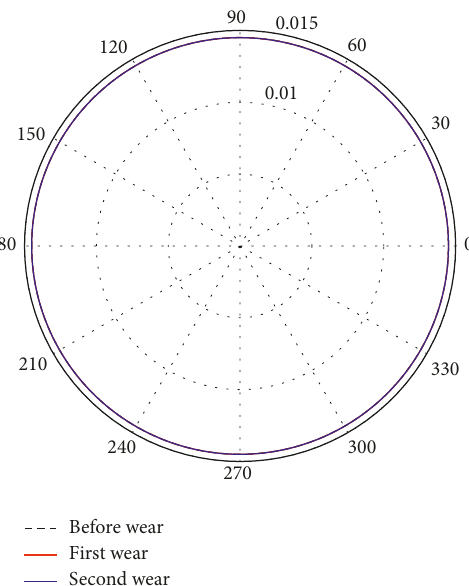
Figure 6: Wear depth of joint B .